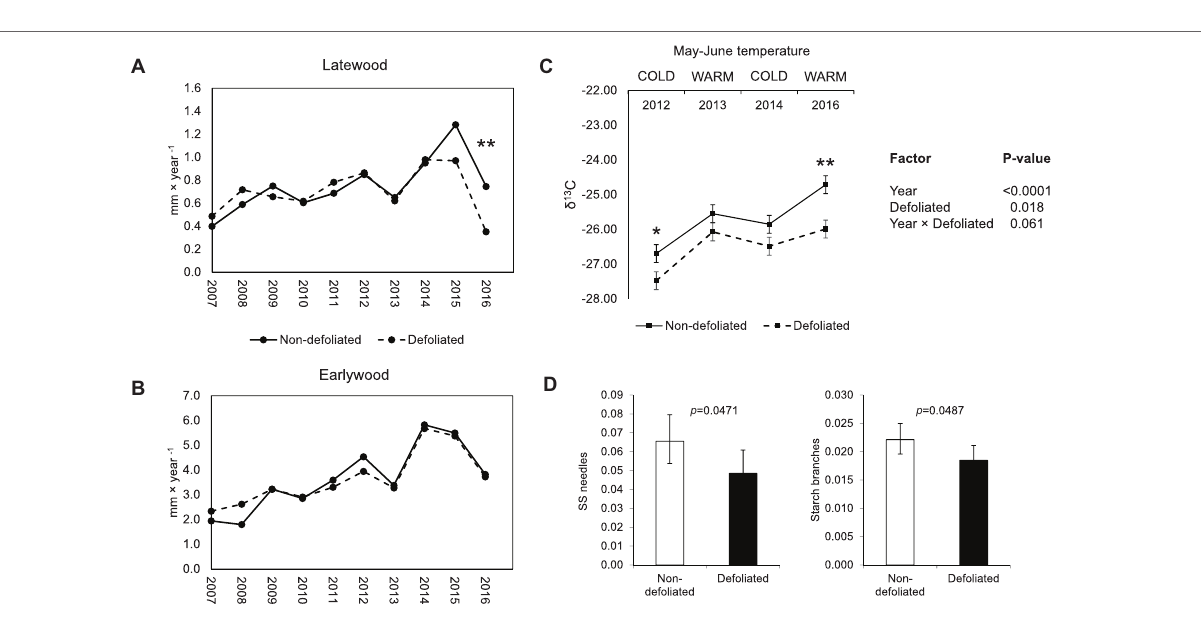
FIGURE 5 | Comparative physiological performance between trees defoliated by D. sapinea ( n = 12 trees) and non-defoliated trees ( n = 12 trees). Latewood (A) and earlywood (B) widths in the period 2007–2016. (C) Carbon isotope ratio ( δ 13 C) comparison between defoliated and non-defoliated trees across years when tree growth was high and spring conditions were cold (2012 to 2014) and years when spring was warm and growth was low (2013 and 2016). (D) Soluble sugar (SS) and starch concentration (% of dry weight) differences between defoliated and non-defoliated trees in needles and branch sapwood. Significant levels: ** p < 0.01, * p < 0.05.